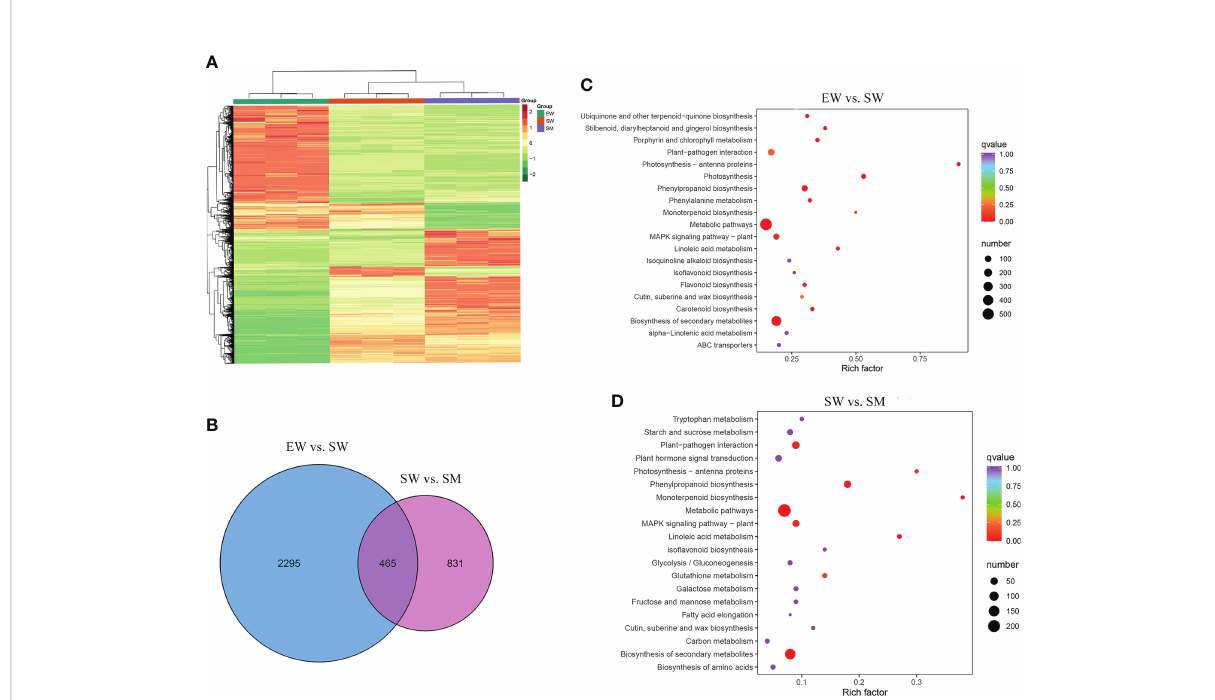
FIGURE 3 The differentially expressed genes (DEGs) induced by melatonin under hypocotyl shading conditions. (A) Hierarchical clustering of DEGs. (B) Venn diagram of unique and common DEGs. (C, D) KEGG pathways enrichment analysis of DEGs. EW (hypocotyl exposed and irrigated with water), SW (hypocotyl shaded and irrigated with water) and SM (hypocotyl shaded and irrigated with 100 µM